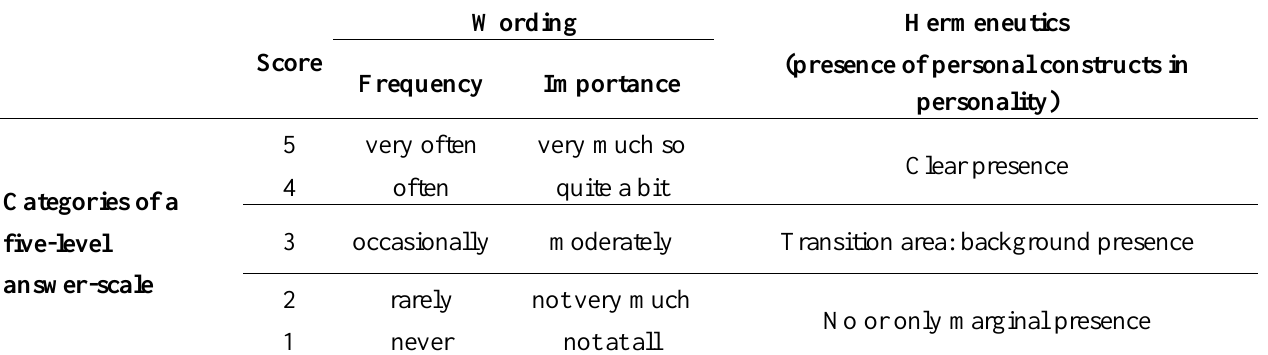
Table 4. Hermeneutics of the wording a five level answer